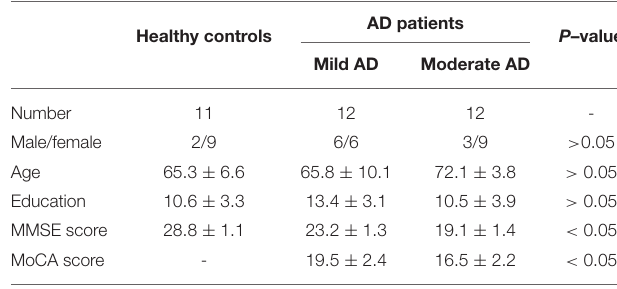
TABLE 1 | Demographic and clinical information of all participants. AD Healthy controls